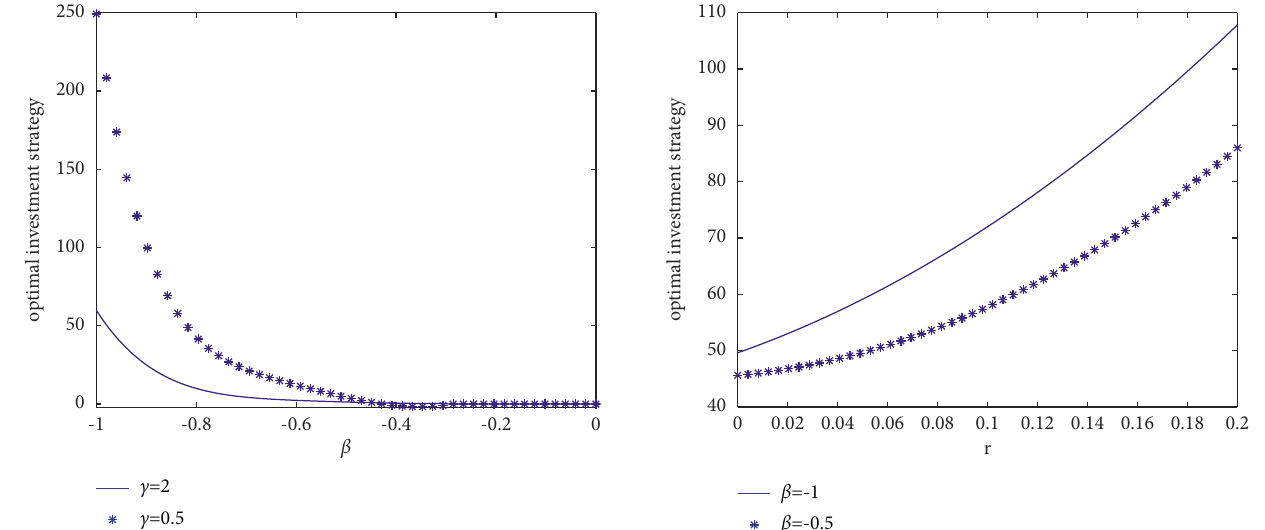
Figure 7: Influence of r on optimal consumption ratio C ∗ t .